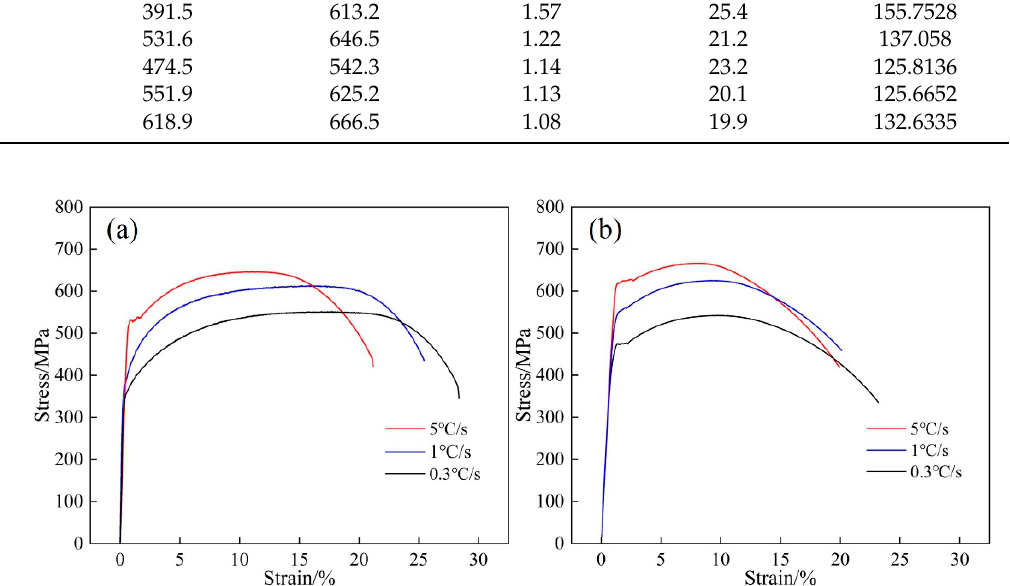
Figure 13. The engineering stress–strain curves for ( a ) steel 1# and ( b ) steel 2# at different cooling rates.